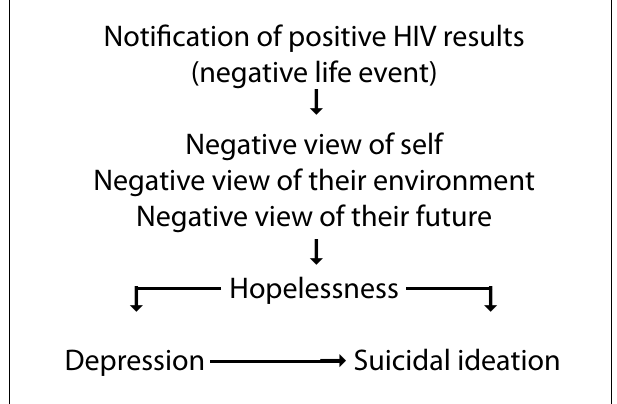
Fig. 3. Flow diagram linking seropositivity, hopelessness, depression and suicidal